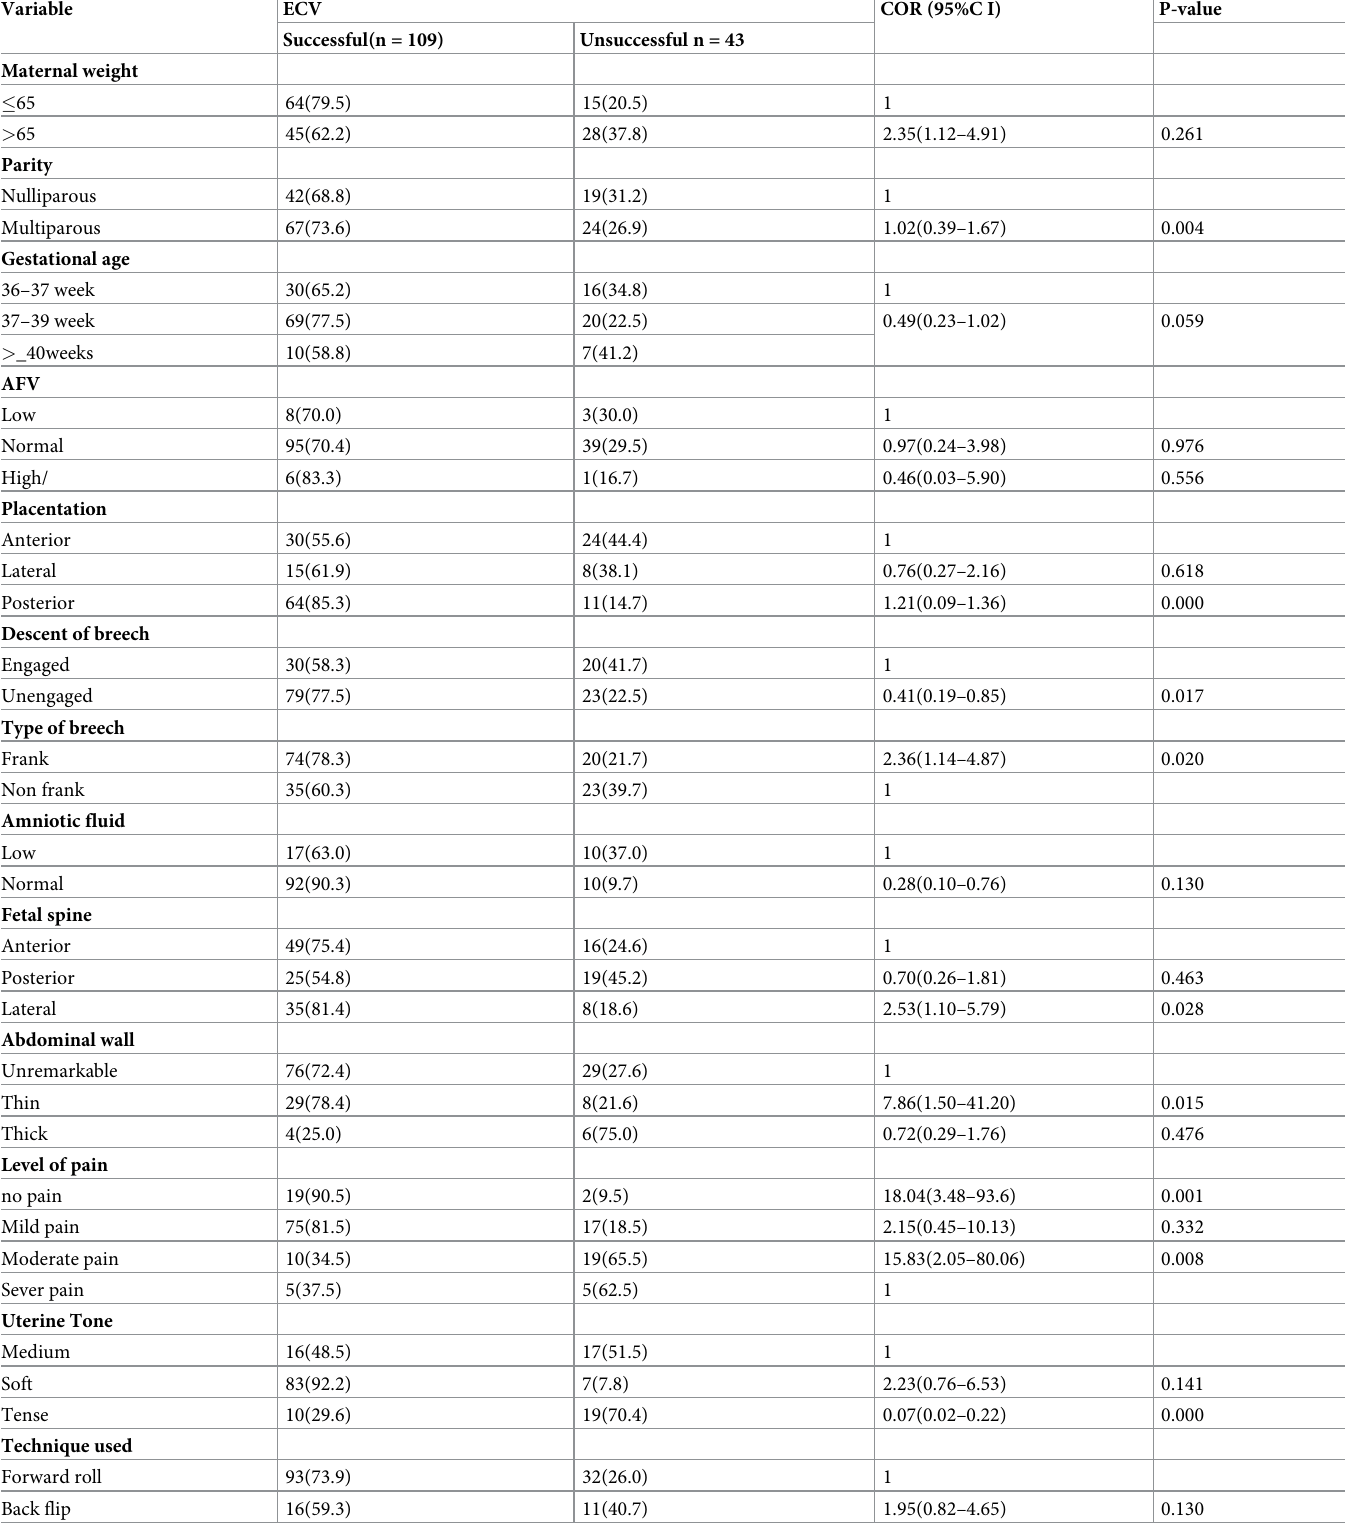
Table 3. Bivariate analysis of predictors of successful